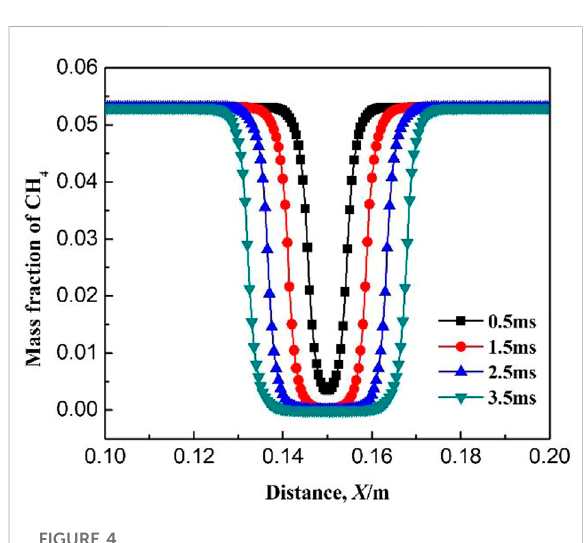
FIGURE 4 Variation of mass fraction of CH 4 .